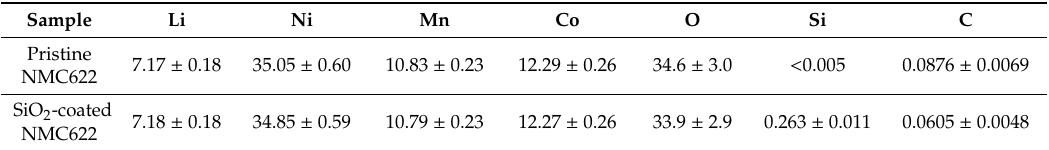
Table 1. Elemental analysis results of pristine and SiO 2 -coated NMC622 material by ICP-OES, HE, and C / S